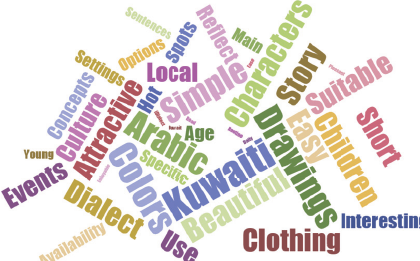
Figure 6: Word cloud representation of responses indicating the most preferred features of the app.